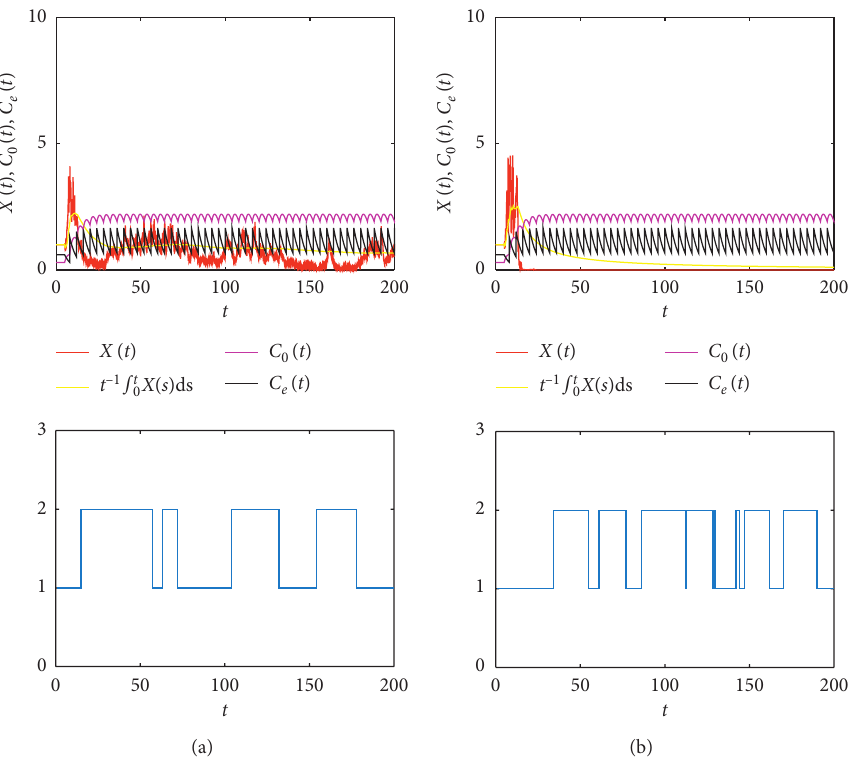
Figure 3: Effect of the L´evy noise: (a) c ( 1 ) � 3 , c ( 2 ) � 3; (b) c ( 1 ) � 10 , c ( 2 ) � 10.